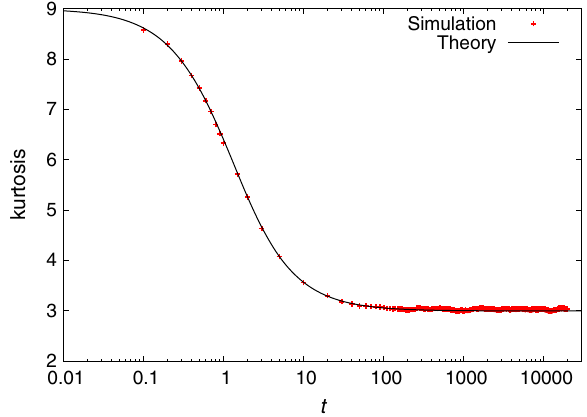
FIG. 3. The kurtosis K for d ¼ n ¼ 1 defined in Eq. (57), based on relations (1) and (55), is shown by the solid line; simulation results are represented by the symbols. The crossover occurs at the correlation time τ ¼ 1 . Over the entire displayed time range, the agreement between theory and simulations is